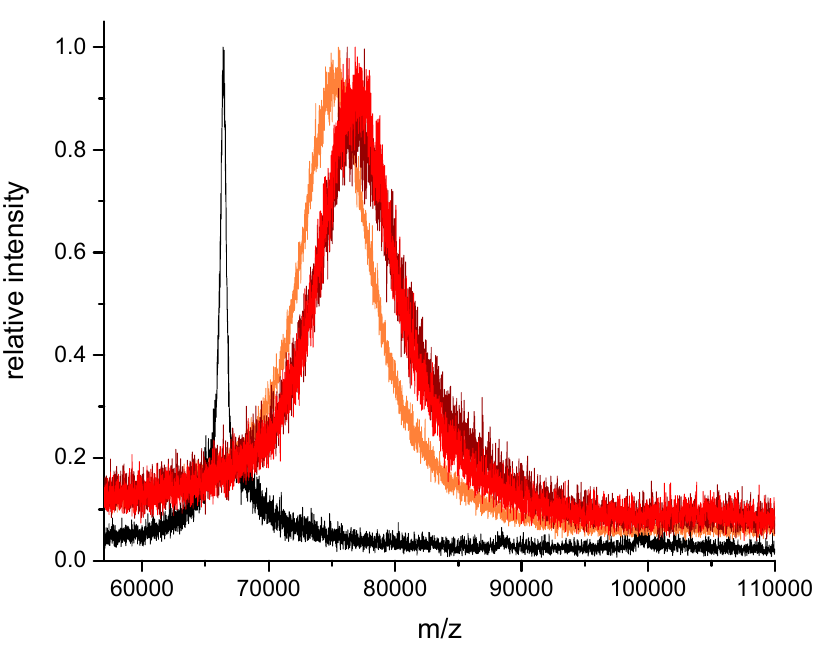
Figure 7. Protocol II (activation limited): Conjugation of cysteine-containing model peptide with SIA-activated serum albumin (BSA). BSA: black, BSA + SIA + Peptide 1:20: orange, BSA + SIA + Peptide 1:30: brown, BSA + SIA + Peptide 1:40: red.